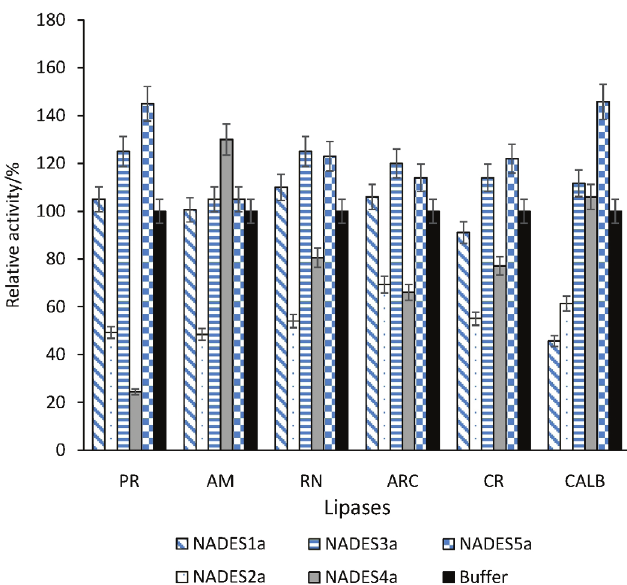
Fig. 1 – Screening of different lipases with several NADESs. Phosphate buffer (pH 7.0) was used as a reference for each li- pase’s control as a comparison. Lipase from porcine pancreas (PR), lipase from Candida rugosa (CR), Amano lipase PS, from Burkholderia cepacia (AM), lipase from Rhizopus niveus (RN), lipase acrylic resin from Candida antartica (ARC) (recombi- nant, expressed in Aspergillus niger), Lipase B Candida antar- tica immobilized on Immobead 150, recombinant from Asper- gillus oryzae